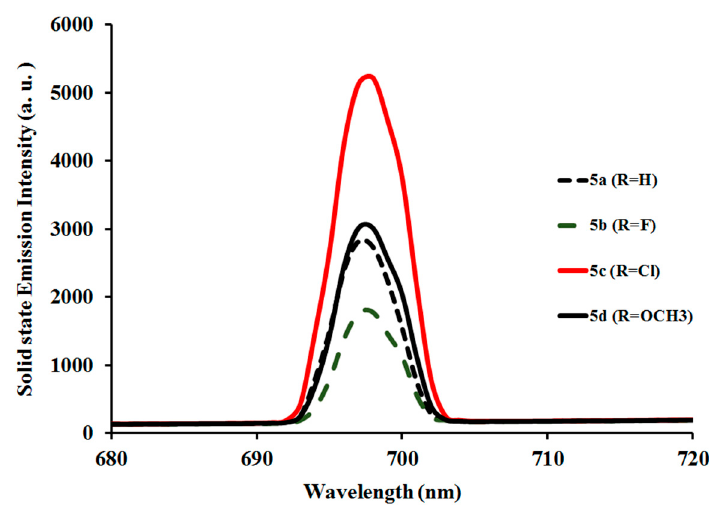
Figure 10. Solid state phosphorescence emission spectra of (Ir( 5a – d ) 3 ) at λ ex = 350 nm at RT.